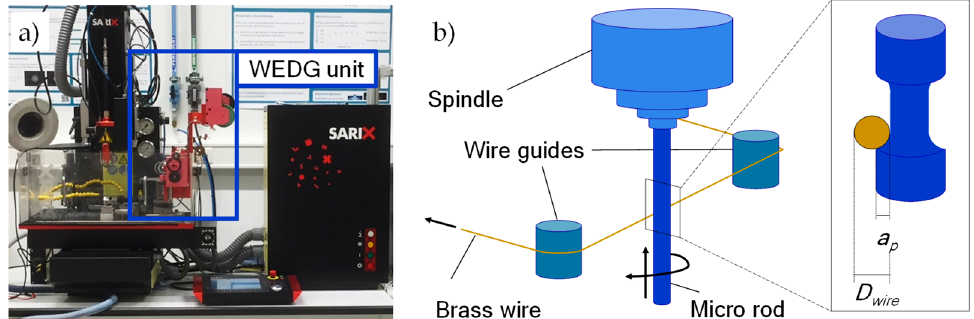
Figure 3. ( a ) Experimental setup and ( b ) schematic view of the wire electrical discharge grinding (WEDG) process. In the magnified view in (b), the wire diameter ( D wire ) and the depth of cut ( a p ) are indicated. The figure is adapted from [34].